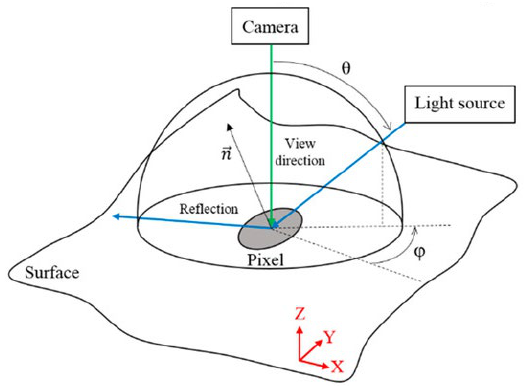
Figure 2. Scheme of reflectance principle—extracted from [57].